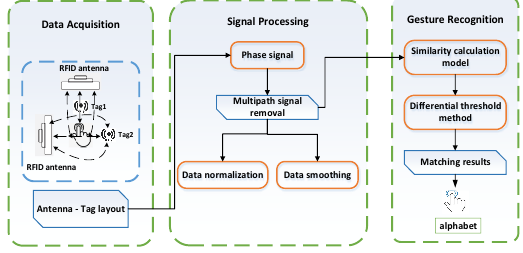
Figure 1. The system structure of RF-alphabet.